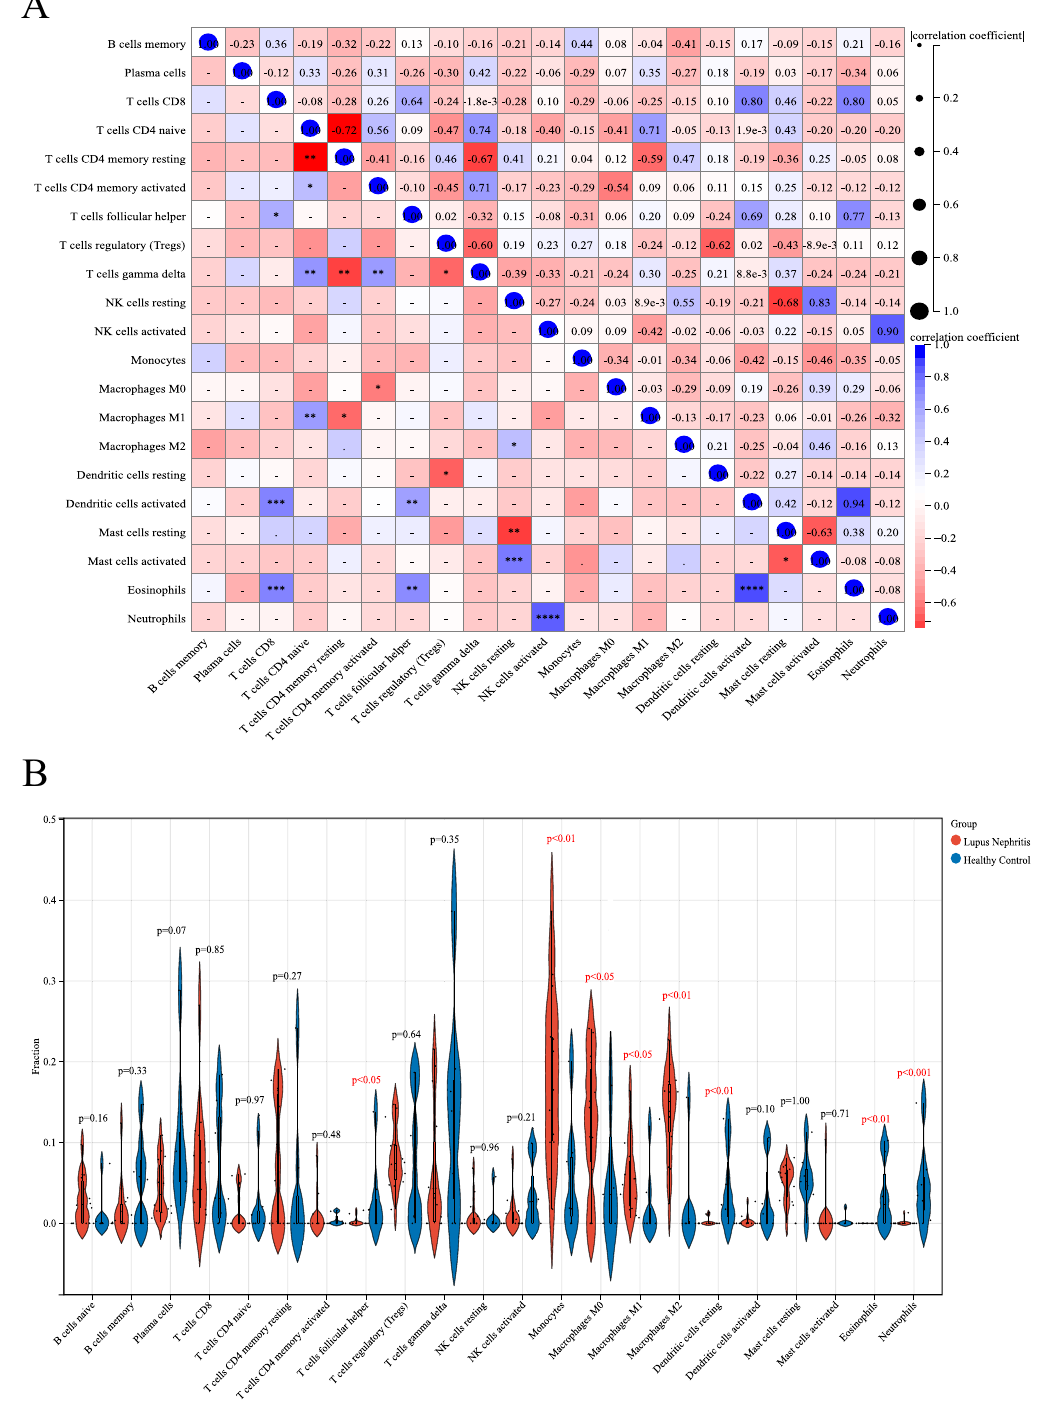
Figure 6. Correlation analysis and bar plot of differences among immune cells in the LN group. ( A ) Correlation analysis. Blue indicates a positive correlation and red indicates a negative correlation; the higher is the absolute value, the stronger is the correlation between immune cells. ( B ) Violin chart showing the proportion of each immune cell type between healthy and LN samples; blue corresponds to healthy samples and red to LN samples, P <